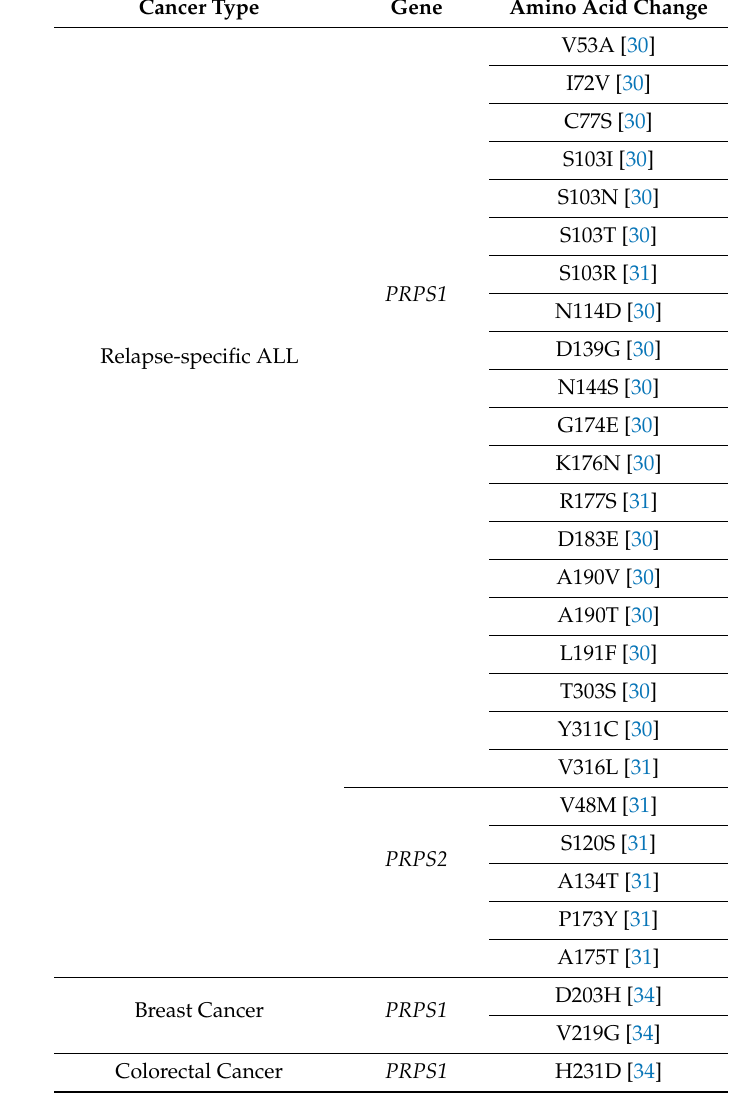
Table 2. Missense mutations of PRPS identified in human